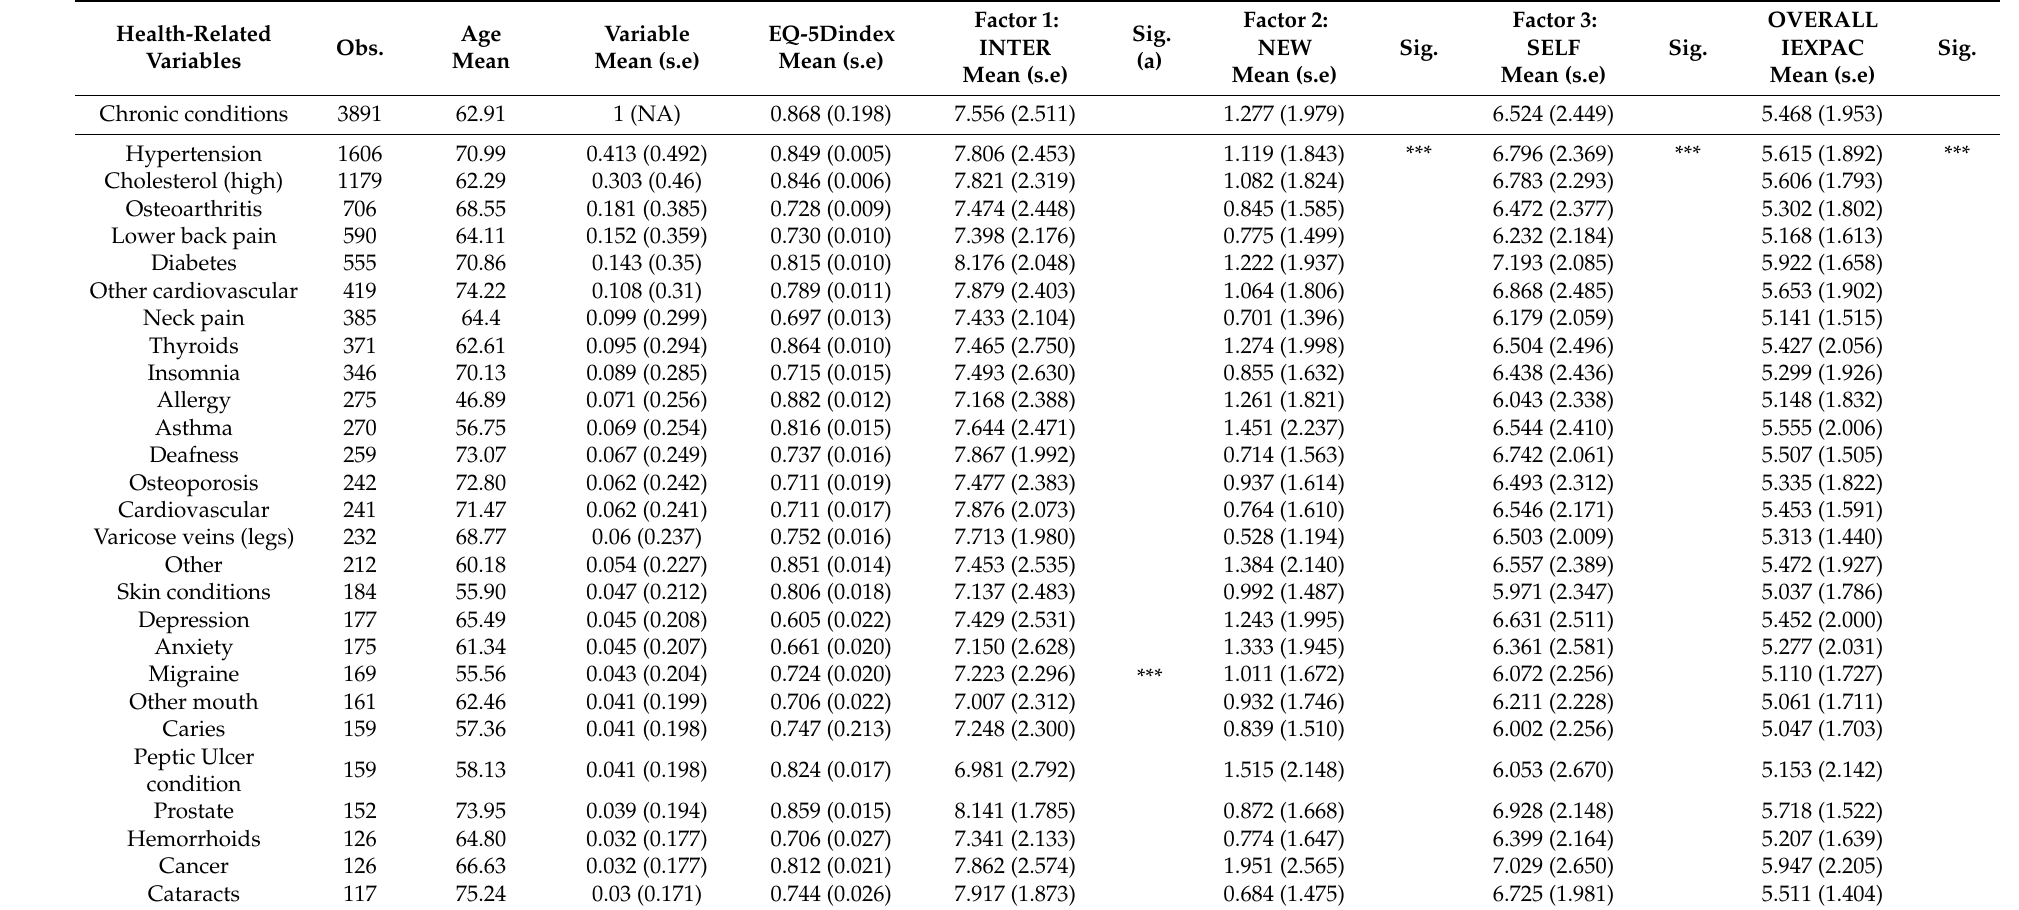
Table 2. Health-related variables. Descriptive